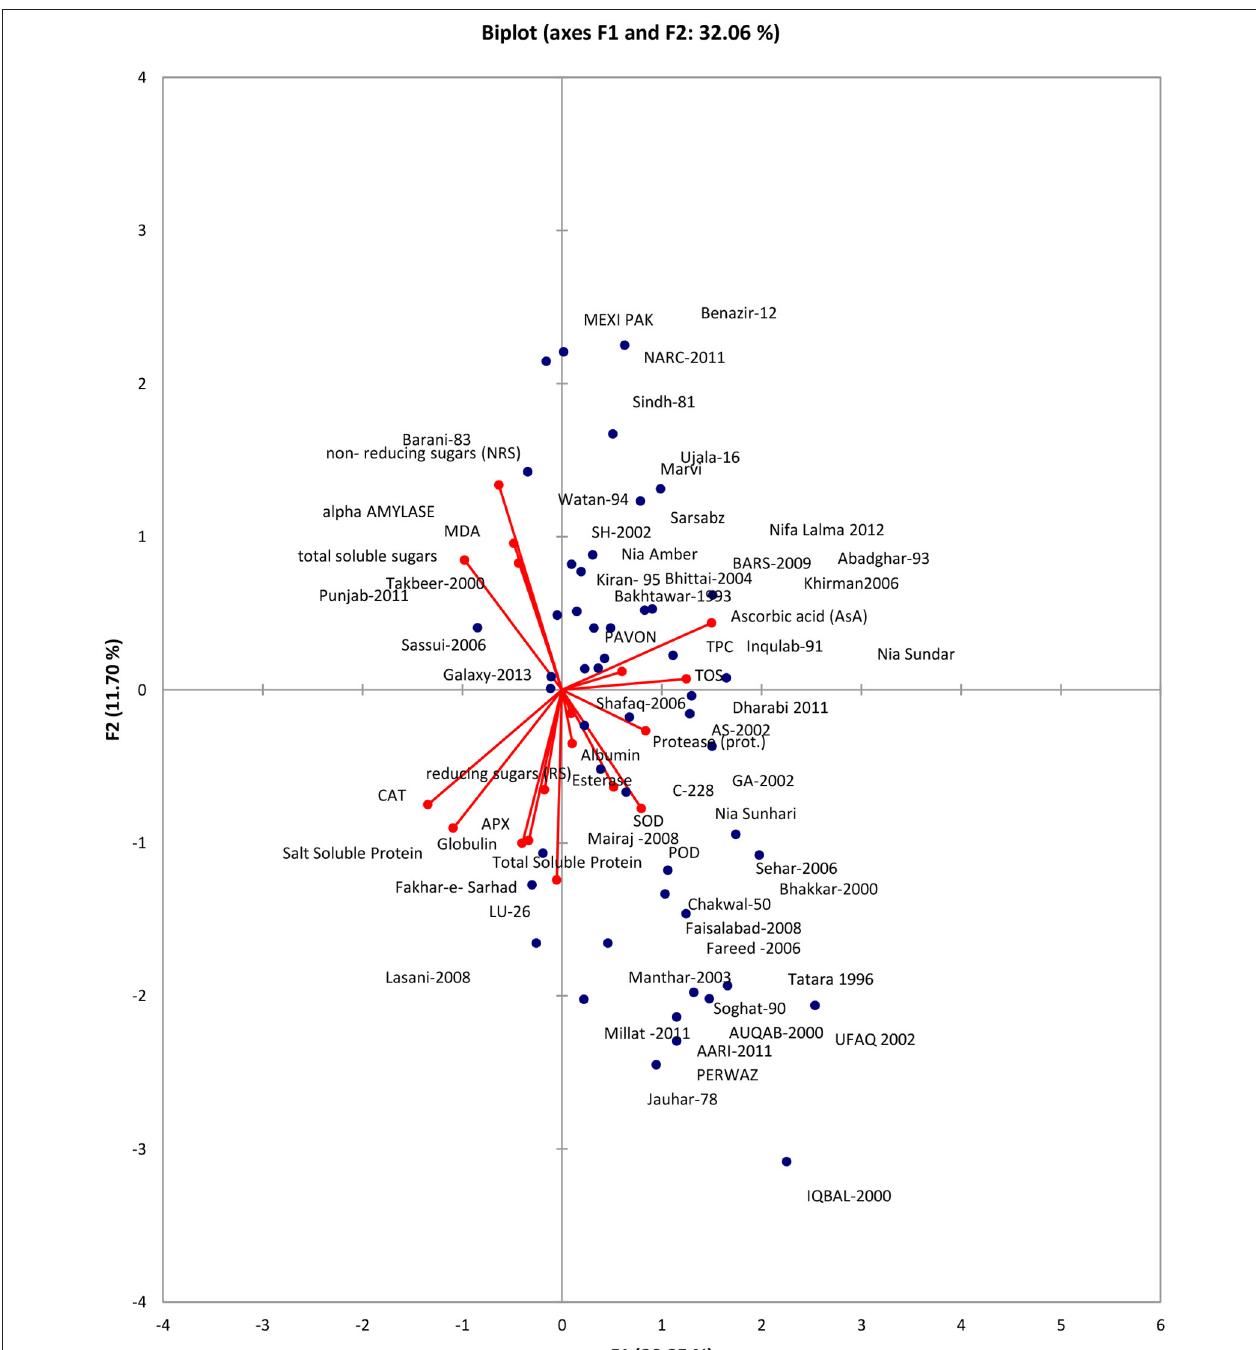
FIGURE 1 | Bi-plot of wheat genotypes for first two principal components.